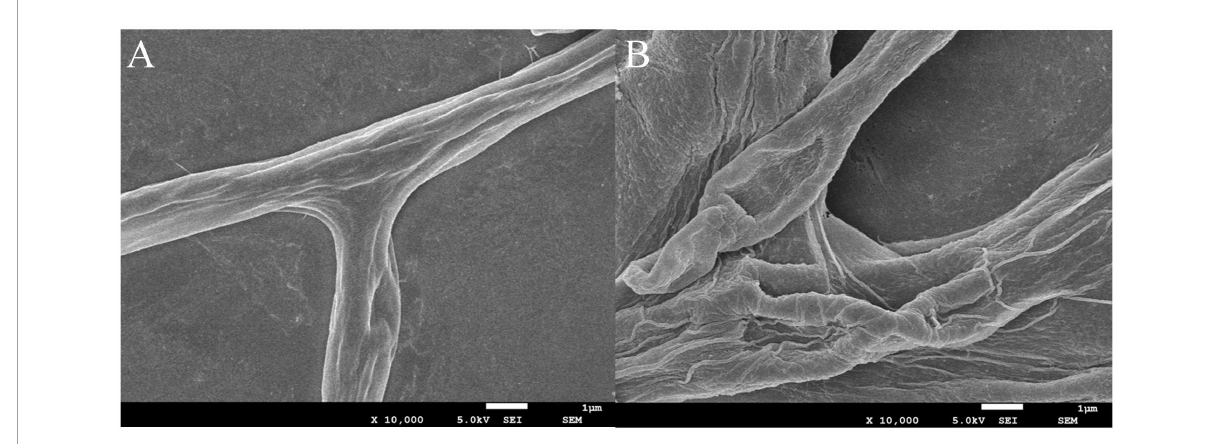
FIGURE8 Effect of JEO on the morphology of B. cinerea . Mycelia treated with sterilized distilled water as the control (A) and EC 50 of JEO (B) were observed by scanning electron microscopy (SEM) at 10,000 × magnification. JEO, juniper essential